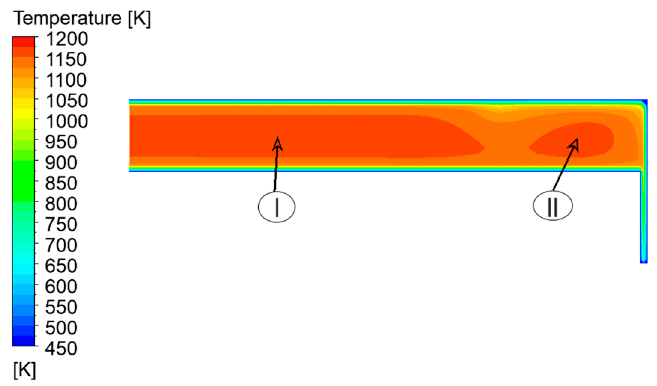
Figure 15. Temperature distribution at 3 CAD BTDC for the flat-piston case without swirl.